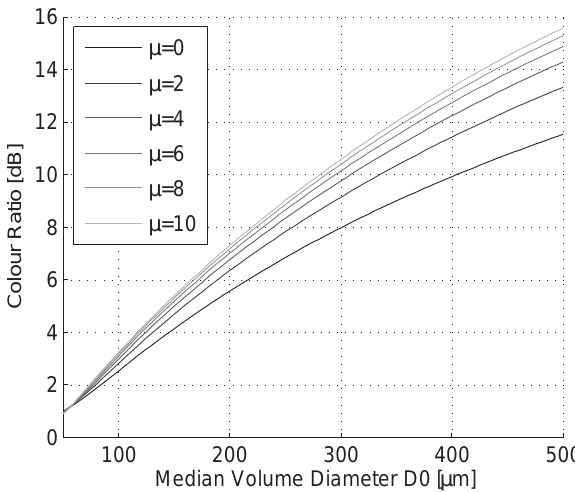
Fig. 3. Ratio of the extinction coefficient at 905nm wavelength to that at 1.5µm for a population of water drops with median volume diameter D 0 . Values of µ are the same as Fig.